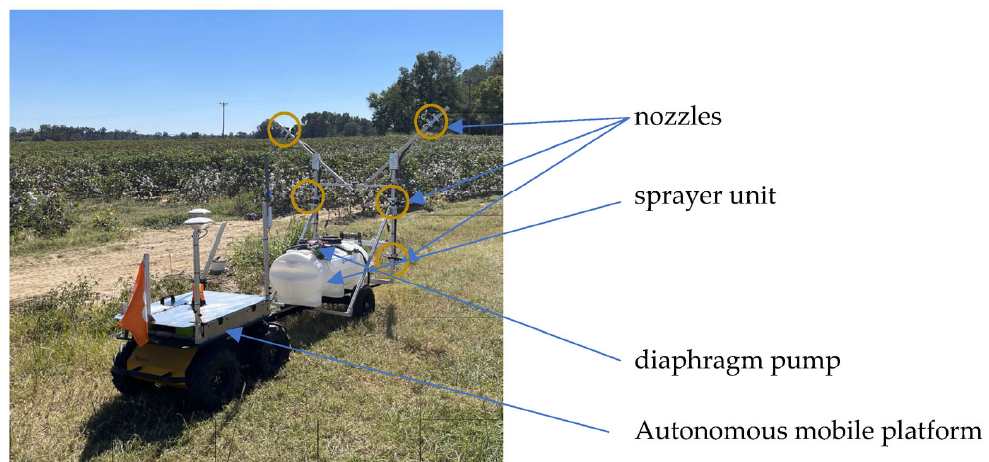
Figure 5. Autonomous mobile platform with the pull behind sprayer.